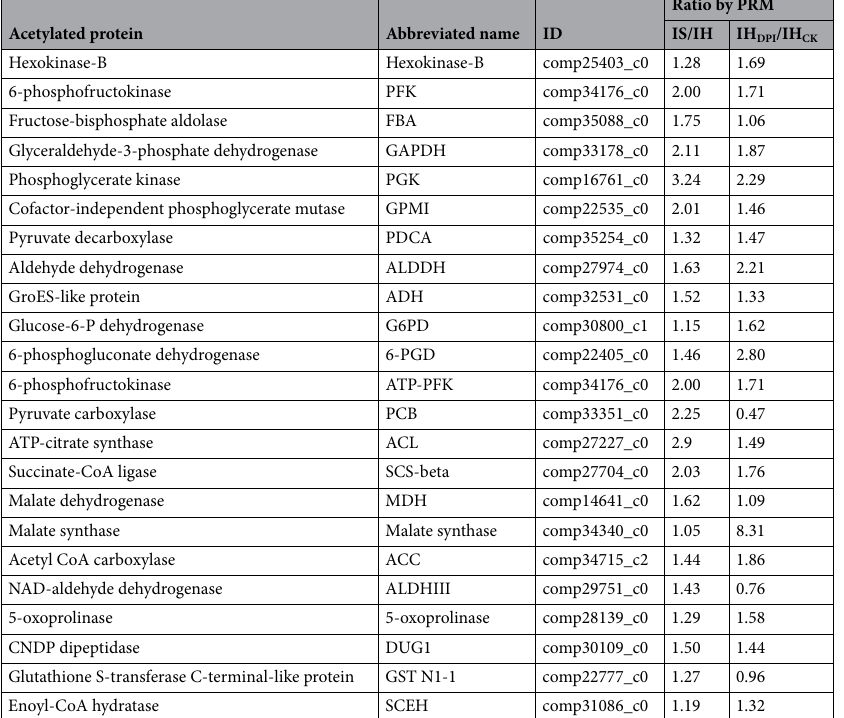
Table 2. Expression levels of targeted acetylation proteins in P.